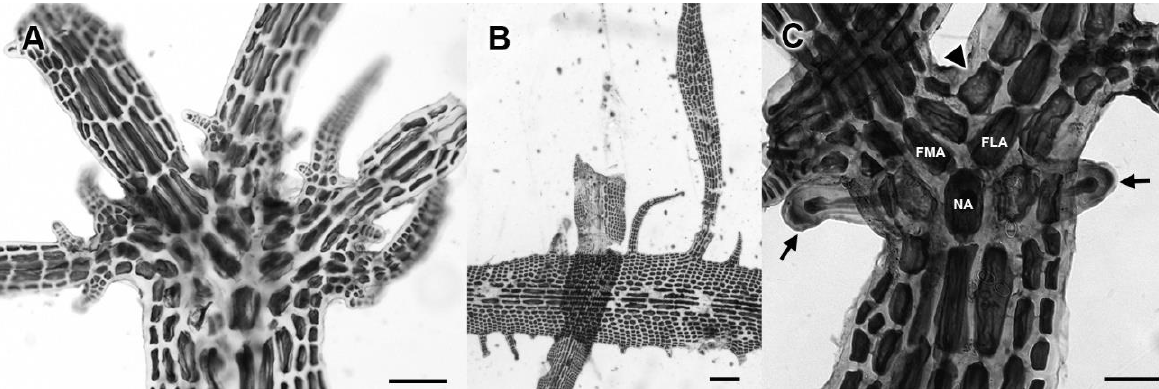
Figure 4. Caloglossa kamiyana sp. nov. ( A ) Proliferous development of adventitious branches at a node, scale = 100 µm. ( B ) Blade with marginal adventitious branches, one well developed and beginning to produce tetrasporangia, scale = 200 µm. ( C ) Cell arrangement at node showing the nodal axial cell (NA) with a single row of cells developing from it towards both margins; the first main axial cell (FMA) with two rows of cells developing from it opposite the lateral axis; the first lateral axial cell (FLA) with an adaxial cell row (arrowhead), and two rhizoid initials (arrows) developing from the lateral pericentral cells of the nodal axial cell, scale = 50 µm.